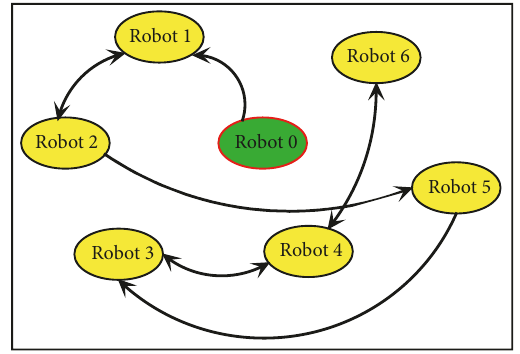
Figure 4: Communication graph among all robots. Leader: robot 0; Followers: robots 1, 2, .. . ,6 (color online).